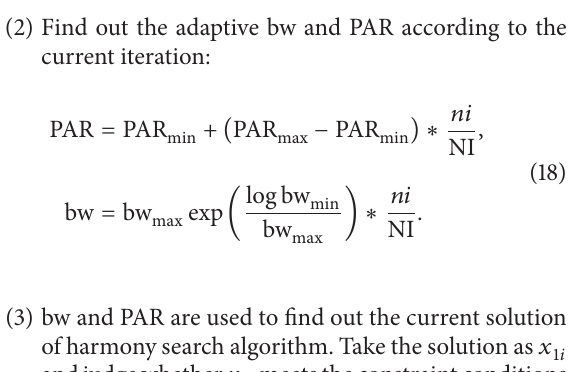
Figure 3: Construction of the initial